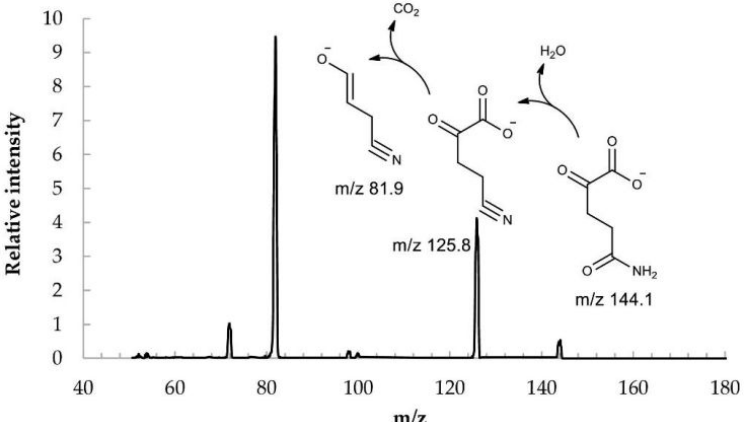
Figure 3. MS/MS spectrum of the synthesized preparation of α -ketoglutaramate (3200 Q TRAP LC/MS/MS System, Applied Biosystems, triple quadrupole). Concentration of KGM was 10 µ M. Solvent—acetonitrile (LC/MS)/water MQ (1:1), direct infusion. Electrospray ionization (ESI-MS), ionization temperature 400 ◦ C. Detection mode—negative ions. IonSpray Voltage 4150 V, declustering potential 15 V, entrance potential 4 V, collision energy 20 eV. Ion peak identification: 3-cyano-prop-1- en-1-olate ( m / z 81.9), 4-cyano-2-oxobutyrate ( m / z 125.8), α -ketoglutaramate ( m / z